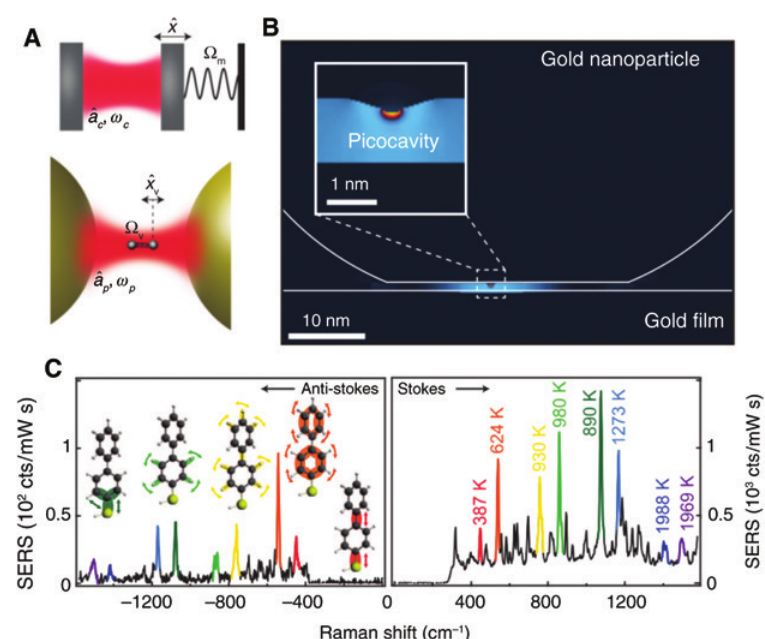
Figure 3: Single-molecule strong coupling in a nanoplasmonics setup. (A) General setup of a molecular optomechanical system [123]. Between a gold nanoparticle and a gold film, plasmon excitations create hotspots of high field amplitude. (B) Optomechanical coupling of single molecules in picocavities [20]. The shown Raman spectra reveal changes of SERS selection rules. (C) Stokes and Anti-stokes spectra. (A) Adapted with permission from Ref. [123] (© 2015 Springer Nature). (B and C) Adapted with permission from Ref. [20] (© 2016 The American Association for the Advancement of